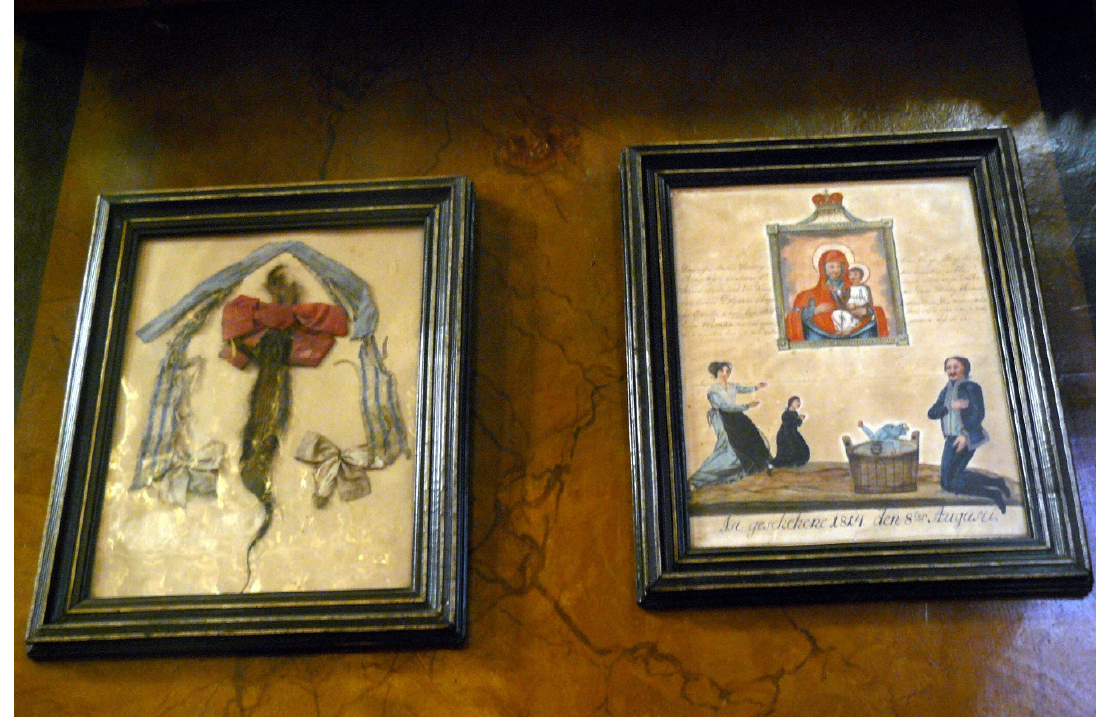
Figure 8. Ex votos in Máriapócs, Photo taken by Krisztina Frauhammer, 2008.